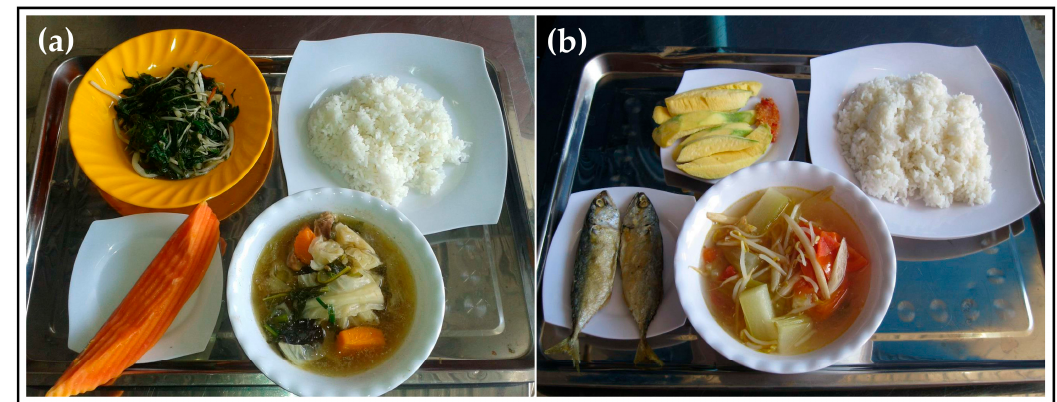
Figure 2. Examples of lunch sets (composed of stir-fry, soup, side item and fruit dessert) served at a garment factory in Phnom Penh, Cambodia: ( a ) stir-fried spinach ( Cha phti ), vegetable soup with pork ( Snau chab chay ), cooked rice and ripe papaya (Set B2); and ( b ) fried fish ( Trey chien ), Vietnamese vegetable soup ( Machu yuan ), cooked rice and mango (Set A5).